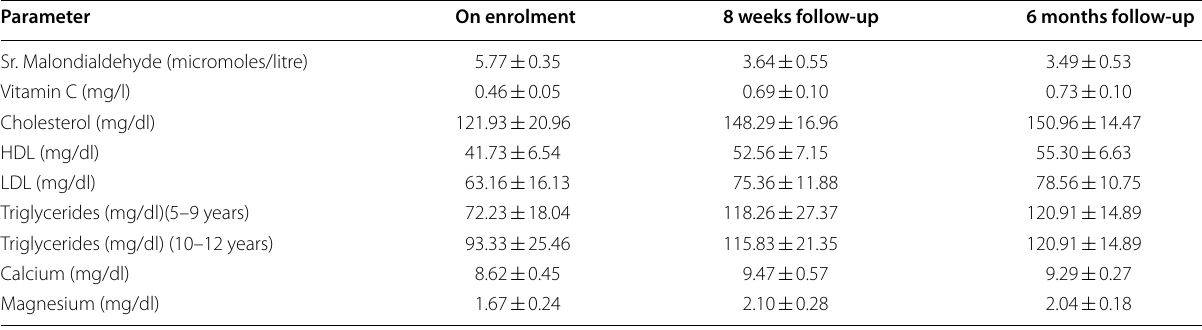
Table 5 Mean values of all biochemical parameters on enrolment, 8 weeks and 6 months